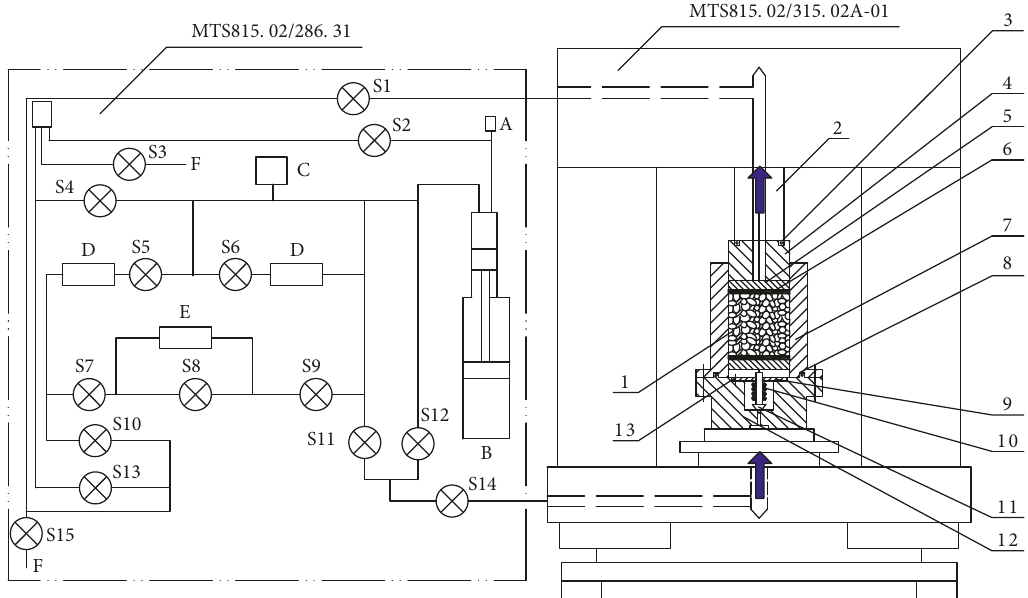
Figure 2: Water flow testing system. A, pressure transducer; B, supercharger; C, relief valve; D, voltage stabilizer; E, differential pressure transducer; F, drainage; S1–S15, switches; 1, crushed rocks; 2, platen; 3 and 8, rubber seal rings; 4, piston; 5, perforated plate; 6, felt pad; 7, cylindrical barrel; 9, plate; 10, spring; 11, valve core; 12, valve chest; and 13, screw.